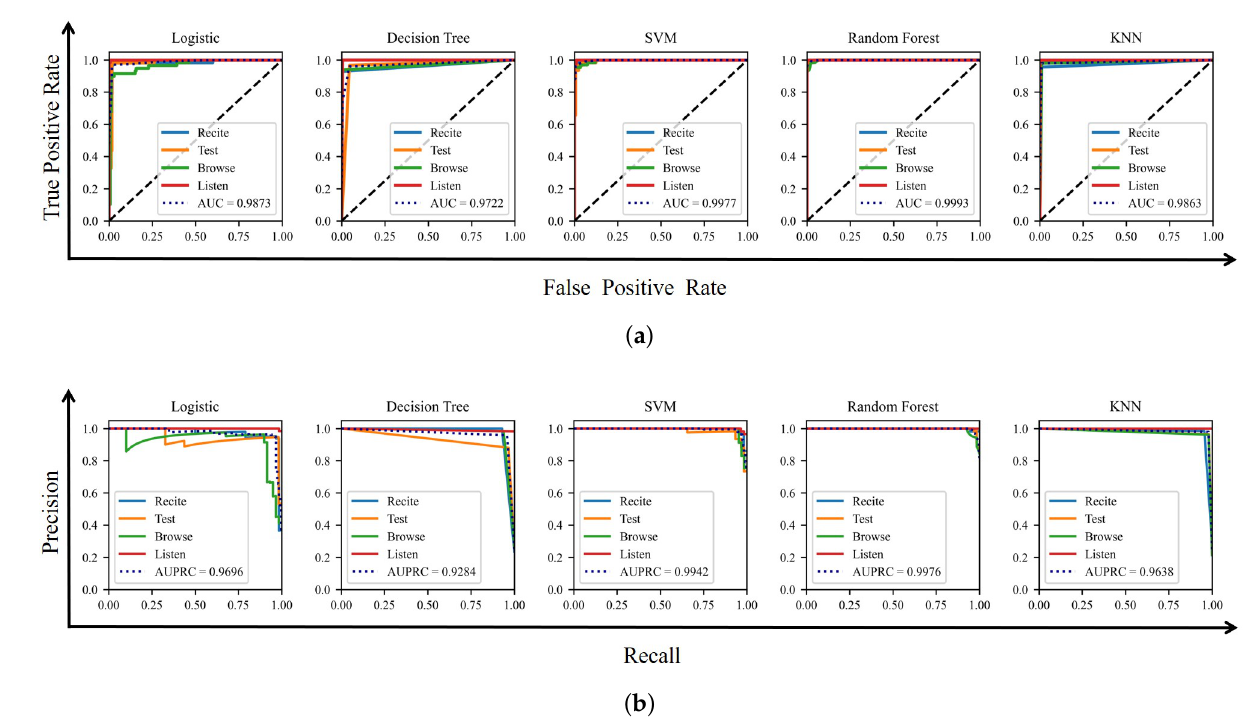
Figure 17. ROC and PRC of different classification models. ( a ) is ROC and ( b ) is PRC.